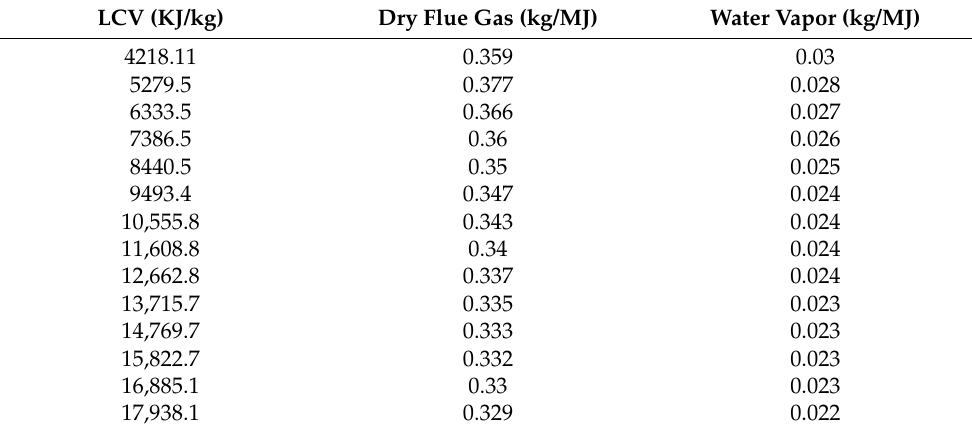
Table 5. Typical combustion parameters for stoichiometric conditions (adapted from [20,21]).